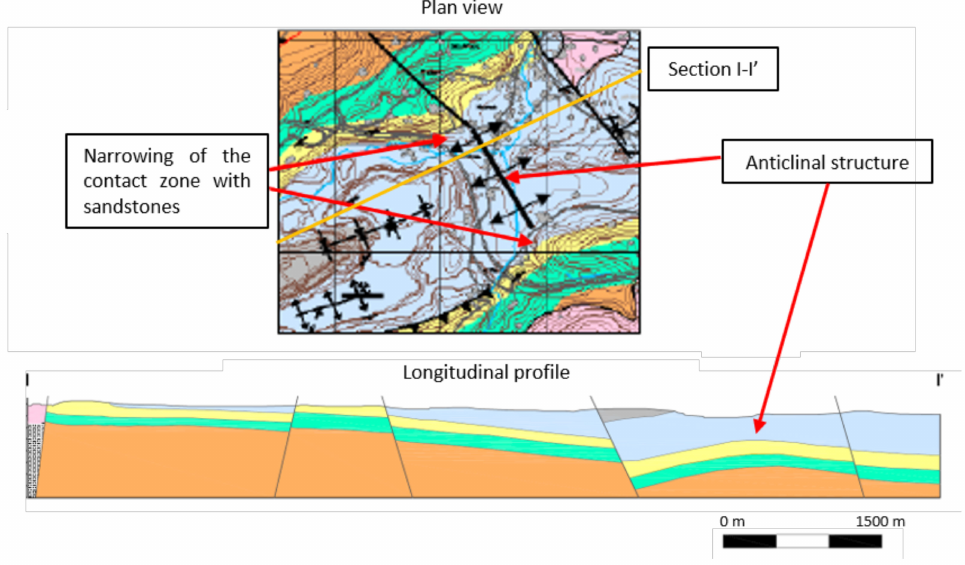
Figure 2. Geological plan view and longitudinal